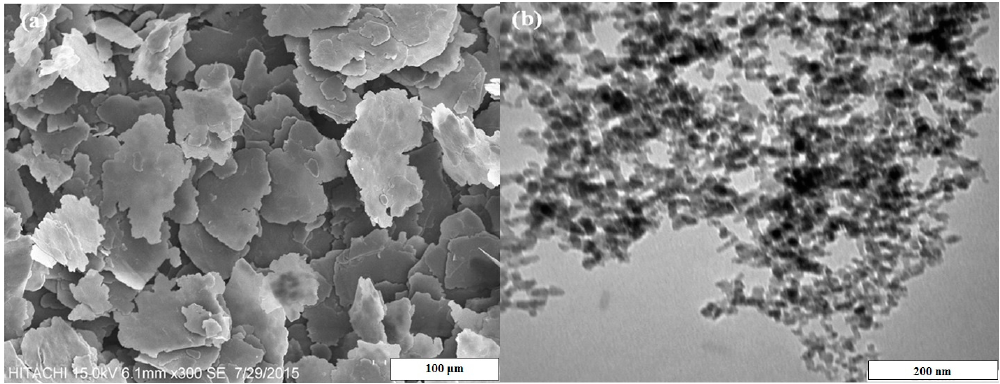
Figure 12. Surface morphology of the as-received ( a ) pure Al and ( b ) Al 2 O 3 powders.